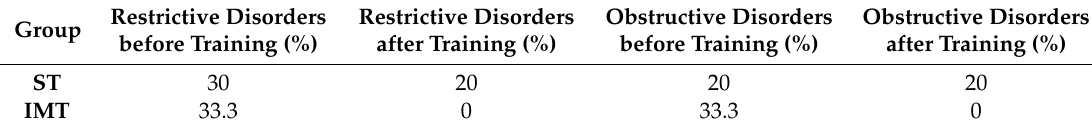
Table 6. Occurrence of restrictive and obstructive pulmonary ventilation disorders in the examined groups.